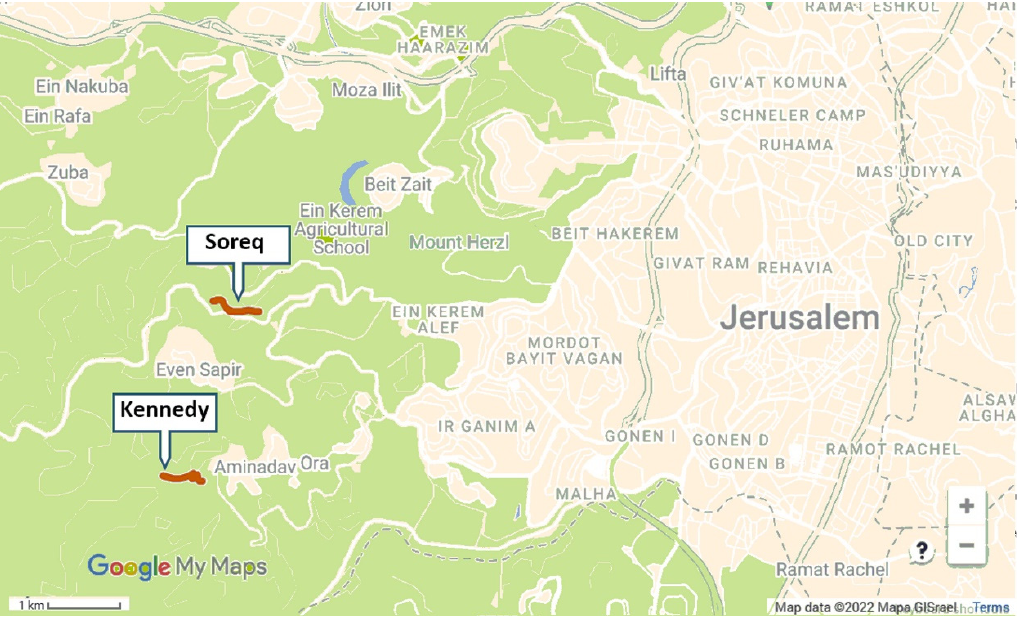
Figure 1. A map showing the locations of the Soreq and Kennedy study sites transects (red bold lines) relative to the western neighborhoods of Jerusalem. (Beige shading—built areas, green shading—open areas).